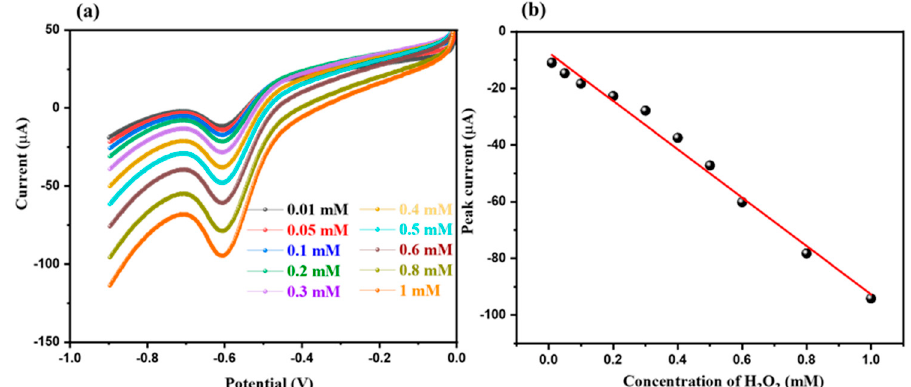
Figure 11. The LSV curves ( a ) of N-rGO/SPCE in the presence of different concentrations of H 2 O 2 (0.01, 0.05, 0.1, 0.2, 0.3, 0.4, 0.5, 0.6, 0.8, and 1.0 mM) in 0.1 M PBS of pH 7.0 at a scan rate of 50 mVs − 1 and the corresponding linear calibration plot ( b ) between the peak current response versus the concentration of H 2 O 2 .